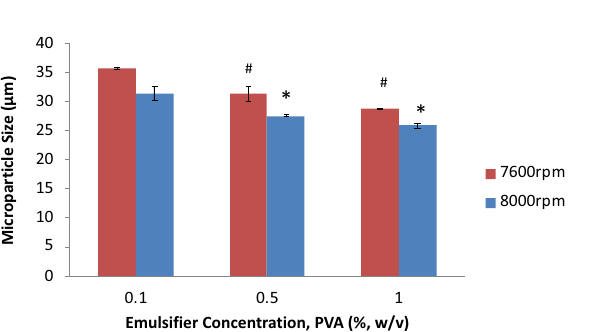
Figure 6. Effect of PVA emulsifier concentration on the size of PCL microparticles homogenized at 7600 RPM. The different emulsifier concentrations caused a statistically significant difference in microparticle size (ANOVA, n = 5, p < 0.05); #, * indicate statistically significant difference compared to 0.1% PVA concentration treatment, for 7600 rpm and 8000 rpm data, respectively (n = 5, p <